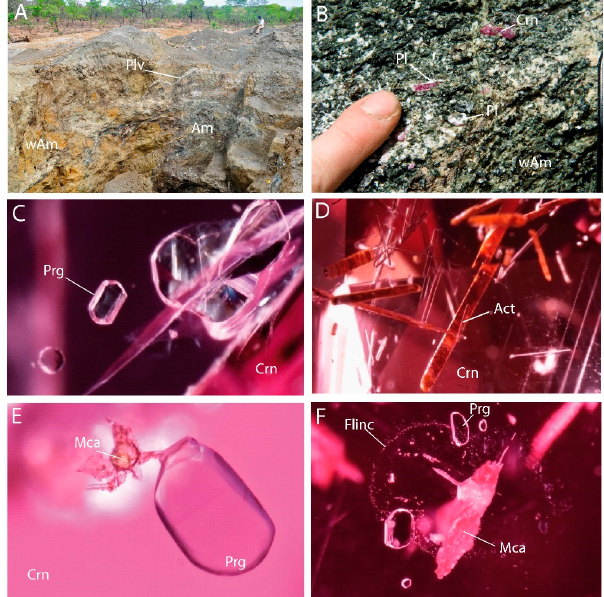
Figure 33. The Mozambican ruby deposits. ( A ) Ruby-bearing amphibolite (Am) at the M’sawize deposit, Niassa Province, 2009. The weathered amphibolite (wAm) is crosscut by whitish plagioclase veins (Plv); ( B ) the Maninge Nice deposit, Concession Gemfields, Montepuez, 2012. The ruby (Crn) is surrounded by a plagioclase corona (Pl, anorthite) in a weathered amphibolite (wAm); ( C ) euhedral pargasite (Prg) in ruby. Field of view 1.5 mm; ( D ) inclusions of actinolite (Act) in ruby. Field of view 2.5 mm; ( E ) crystal of pargasite associated with mica (Mca) in ruby. Field of view 1.1 mm; ( F ) a melted mica (Mca) surrounded by a halo of fluid inclusions (Flinc) arranged in a “butterfly wing” indicative of decrepitation and recrystallization phenomena. The pargasite is euhedral and devoid of deformation. Field of view 1.7 mm. Photos A and B: Vincent Pardieu © GIA. Photos C to F: Jonathan Muyal © GIA. ◦ The texture is granoblastic with 120 triple junctions between amphibole and